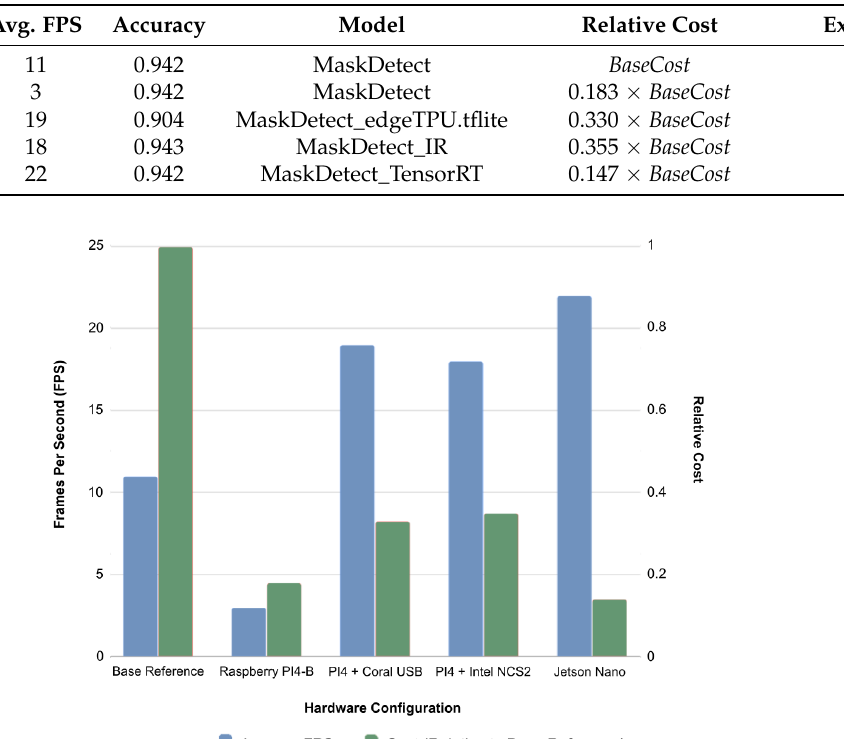
Figure 5. Performance of MaskDetect running on different hardware configurations. Cost of each hardware system measured relative to cost of baseline desktop. The former two hardware configura- tions were with desktop-based MaskDetect; the latter were their optimised variants.